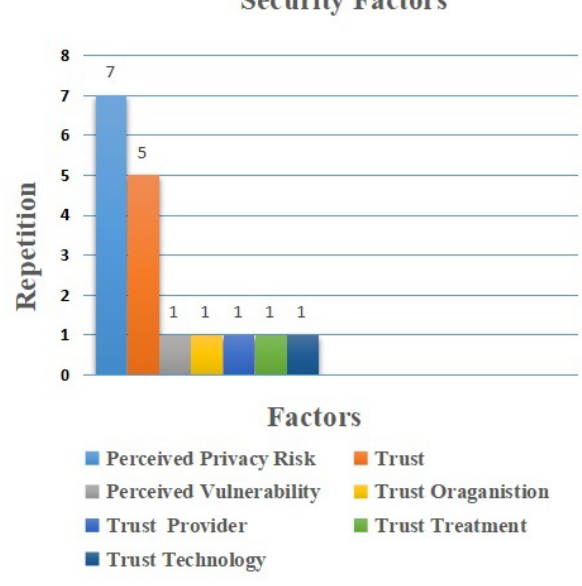
Figure 9. Security